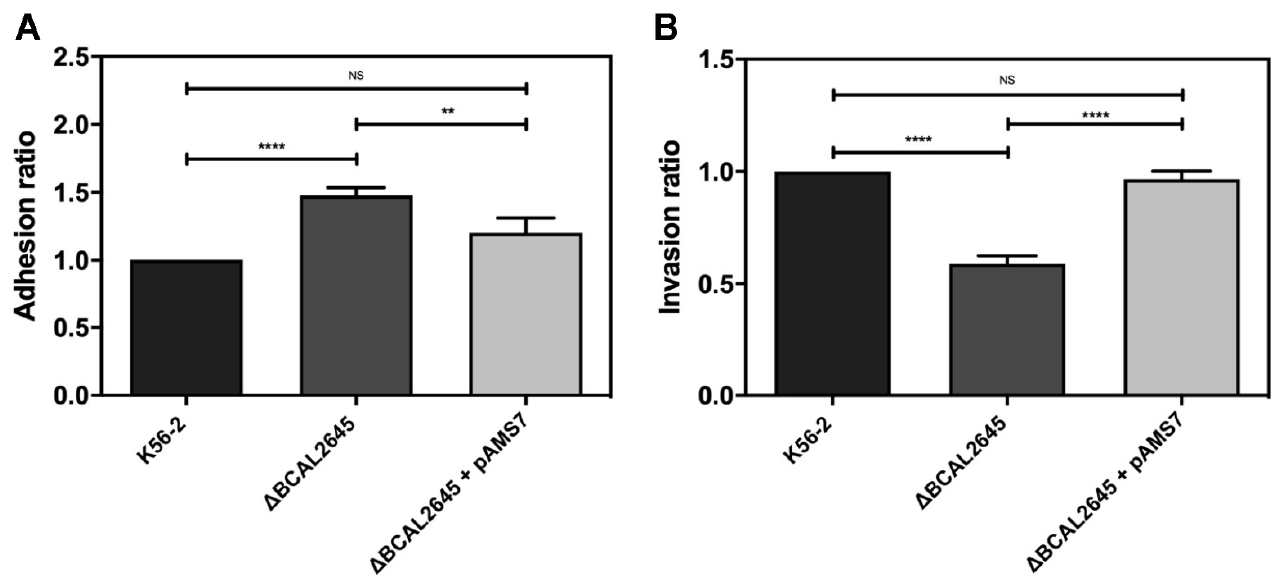
Figure 4. The BCAL2645 gene is required for invasion of B. cenocepacia to the human bronchial epithelial cell line CFBE41o-. ( A ) Adherence to CFBE41o- CF epithelial cell line by the B. cenocepacia K56-2, the Δ BCAL2645 strain and the mutant strain complemented with the BCAL2645 gene (plasmid pAMS7), expressed as a ratio of B. cenocepacia K56-2 adherence. ( B ) Invasion of CFBE41o- CF epithelial cell line by the B. cenocepacia K56-2, the Δ BCAL2645 strain and the mutant strain complemented with the BCAL2645 gene (plasmid pAMS7), expressed as a ratio of B. cenocepacia K56-2 invasion. All the results are from three independent experiments, and bars indicate SD. (****, p < 0.0001; **, p < 0.01, NS, non-significant).